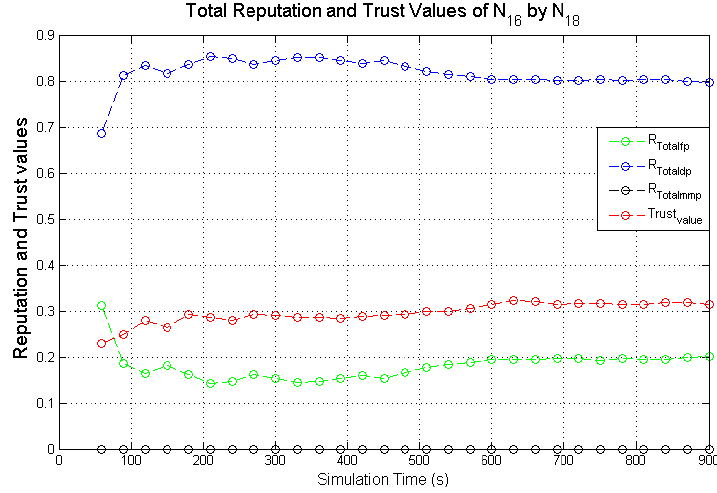
Figure 19. N 16 is selfish and dishonest, N 18 is benevolent and honest.